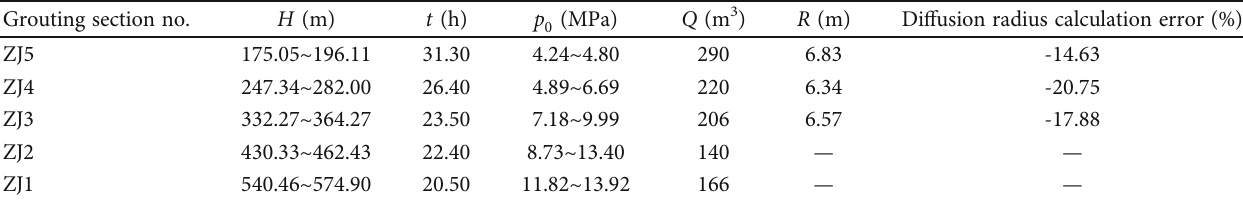
Table 2: Grouting test results of the 3rd wind inspection hole. Grouting section no.